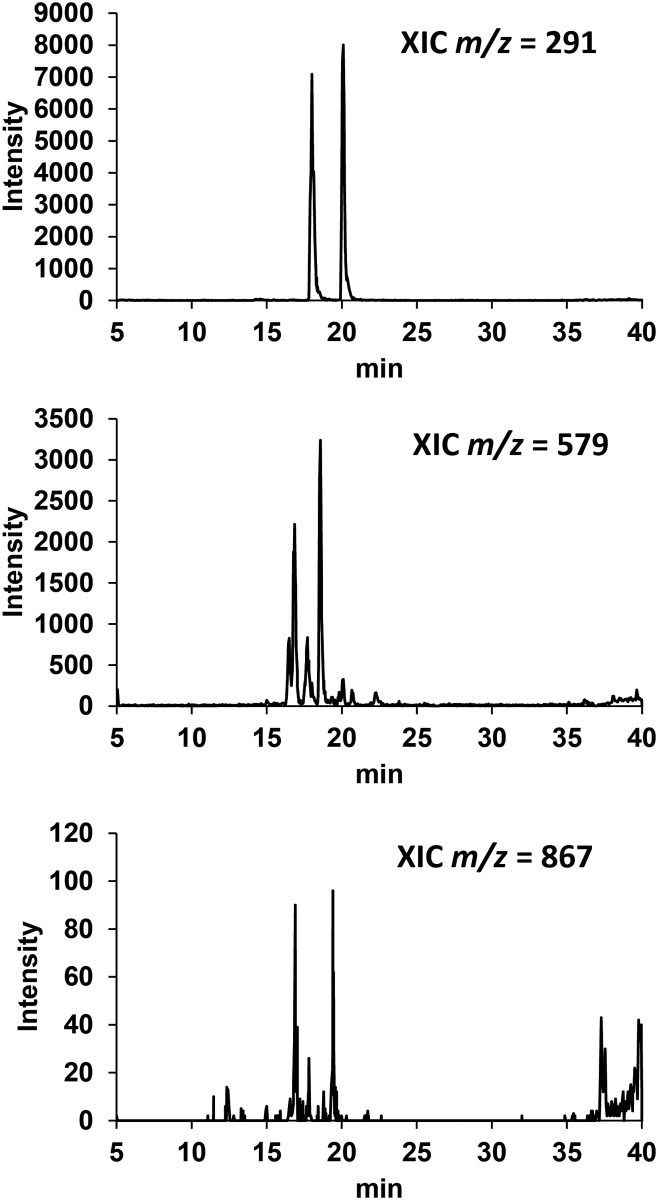
Extracted-ion chromatograms (XICs) with m/z corresponding to catechin monomers, dimers, and trimers.